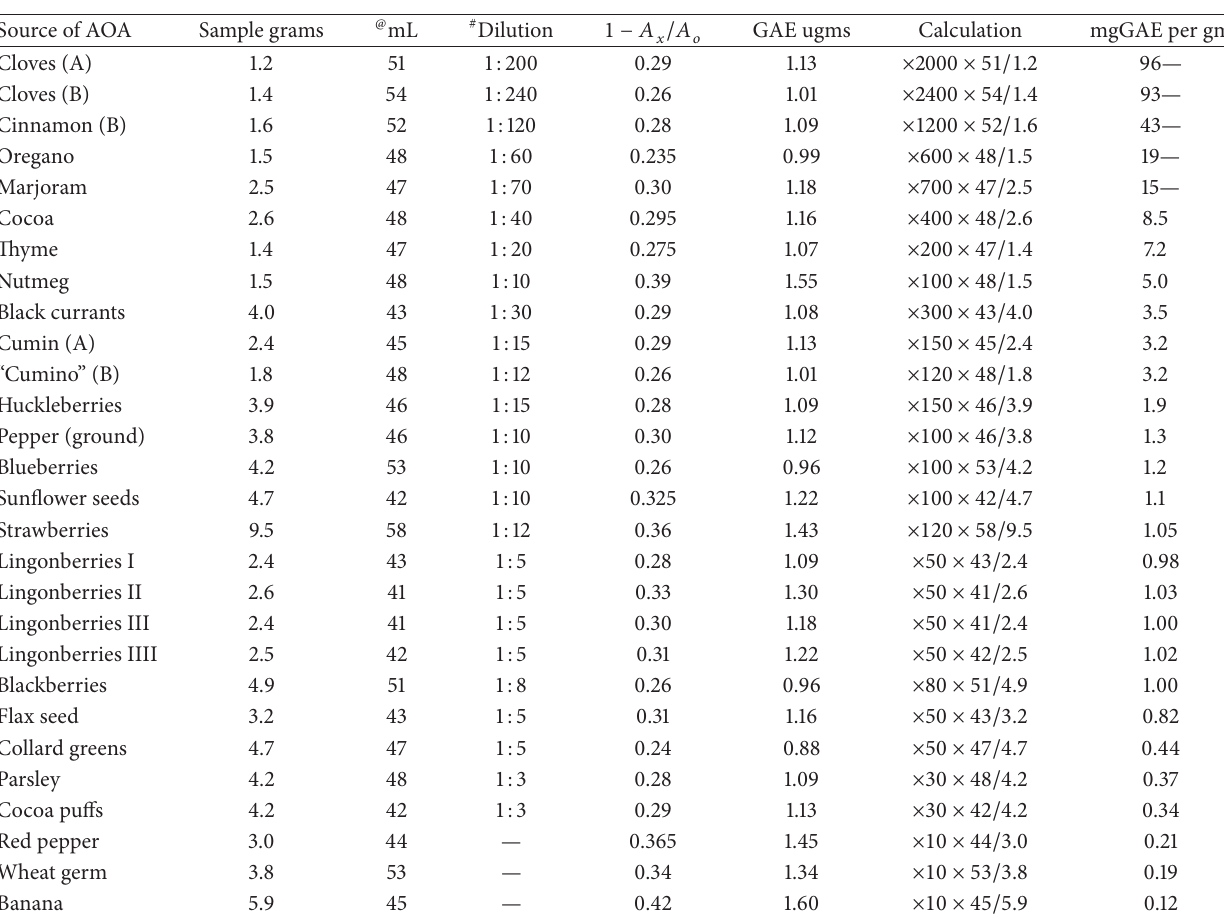
Table 1: Procedure illustrated, aliquots 0.10